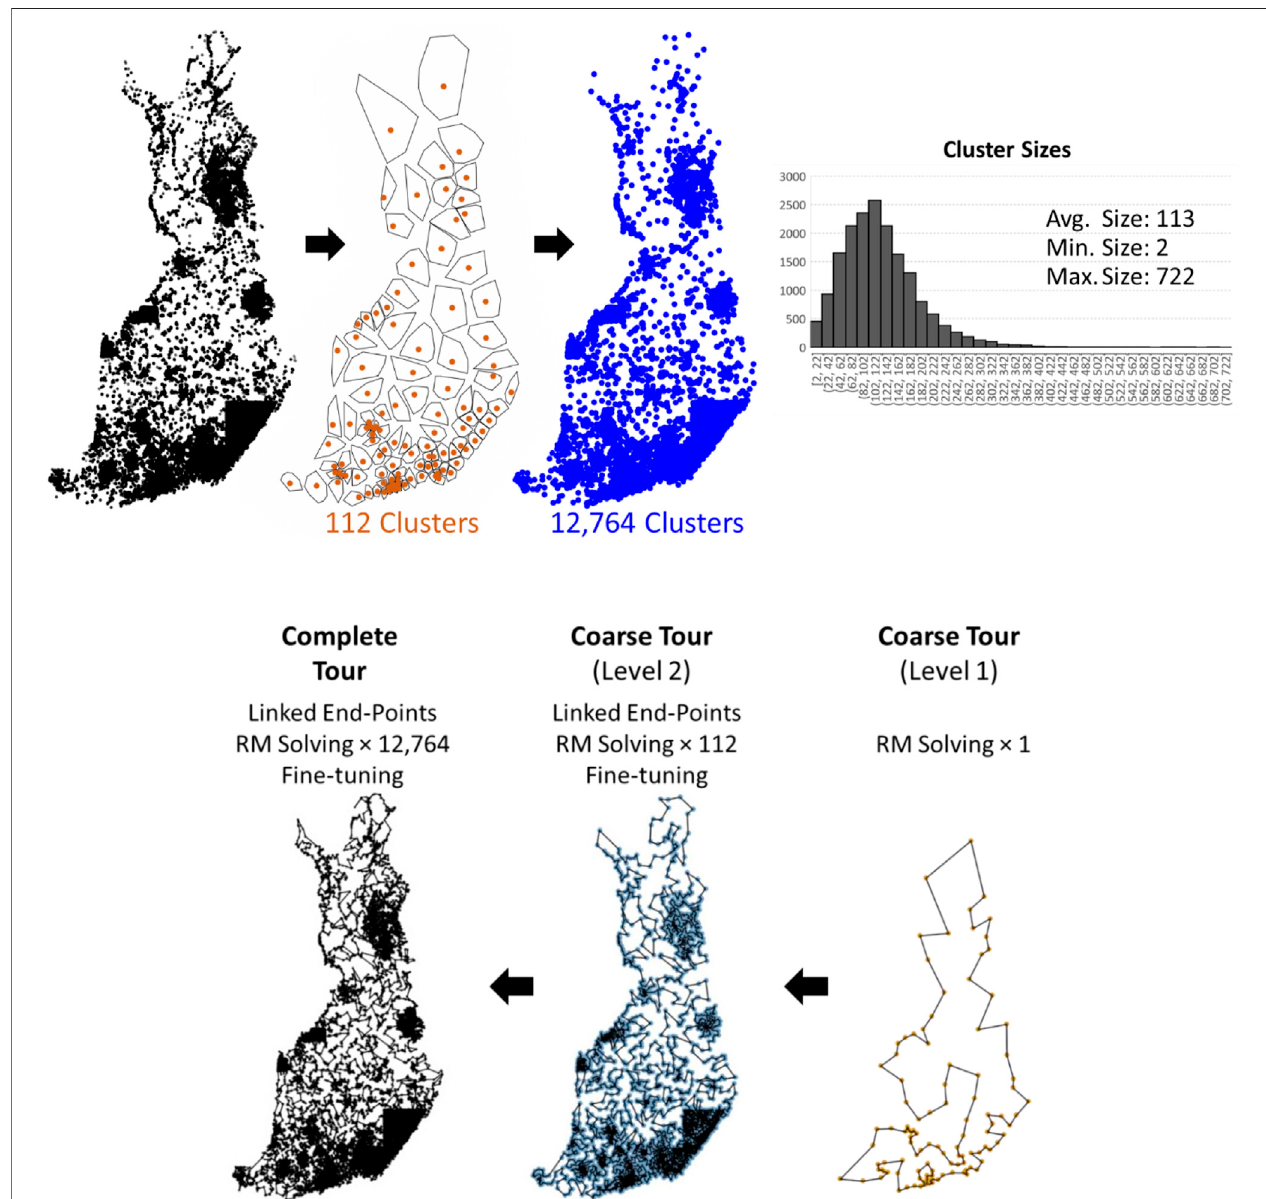
FIGURE 12 | Two-level clusters produced by k-means applied fi rst with k 1 (cid:1) 112 and then repeated for each cluster with k 2 (cid:1) 114 on each of the 112 clusters. A distribution of the cluster sizes is also shown. TSPDiv intermediate steps.